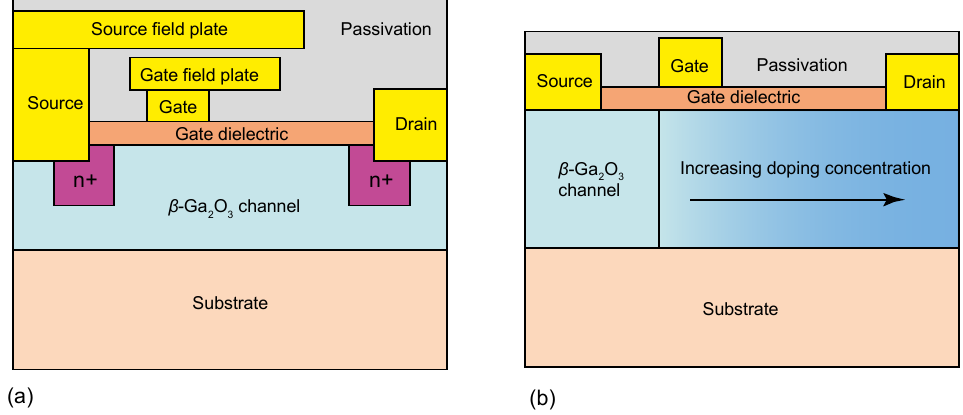
Figure 11. Device structure of the β -Ga 2 O 3 FET with ( a ) gate/source field plate and ( b ) VLD tech ‐ nique.